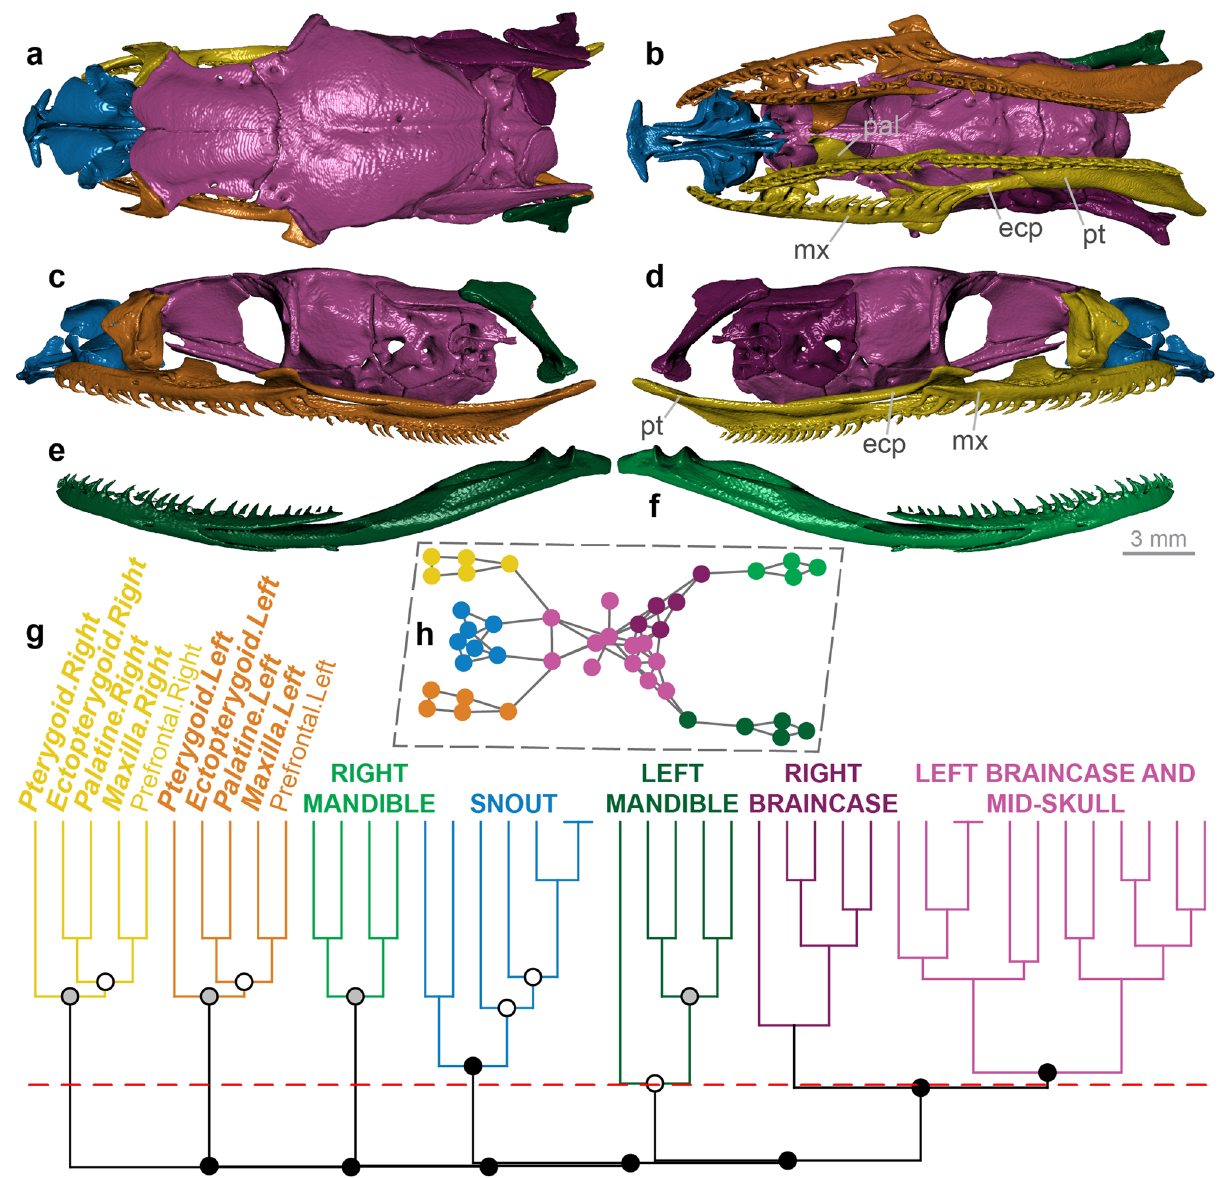
Figure 8. Skull modularity of caenophidian snakes. In caenophidians, the palatomaxillary arches (in italicized boldface) and prefrontals consistently form left and right modules, almost always distinct from all other skull elements (see main text for minor exceptions). ( a–f ) Representative pattern of caenophidian skull modularity, illustrated using Thamnophis radix (UAMZ R636) in ( a ) dorsal, ( b ) ventral, ( c ) left lateral, and ( d ) right lateral views of the skull, and ( e ) left lateral and ( f ) right lateral views of the mandible. ( g ) Network dendrogram of Thamnophis , reflecting this network structure. Q-modules are indicated by Q max (represented by the red dotted line). S-modules are indicated by black (p < 0.001), grey (0.001 ≤ p < 0.01), or white (0.01 ≤ p < 0.05) circles. ( h ) Network representation of the skull of Thamnophis (see Supplementary Fig. S58 for labelled version). ecp ectopterygoid, mx maxilla, pal palatine, pt pterygoid. Dendrogram and network generated in R [v.4.0.3] 122 and RStudio [v.1.3.1093] 123 (see “Methods” section); specimen visualized in Dragonfly [v.4.1] 114 and right palatine-pterygoid-vomer modules and subdivision of the braincase into three modules in Typhlophis (Supplementary Fig. S19). Leptotyphlopidae. Leptotyphlopid scolecophidians are unique among squamates in bearing completely eden- tulous palatomaxillary arches 15,81,83 (Fig. 4a–d). In further contrast to other scolecophidians, which rely on highly kinetic upper jaws for prey ingestion, the palatomaxillary elements are essentially immobile in leptoty- phlopids: the pterygoid and palatine articulate dorsally with the frontal, the palatine is in broad osseous con- tact with the vomer, and the maxilla articulates immovably with the snout 15,16,81,83 (Fig. 4a–d). Leptotyphlopids